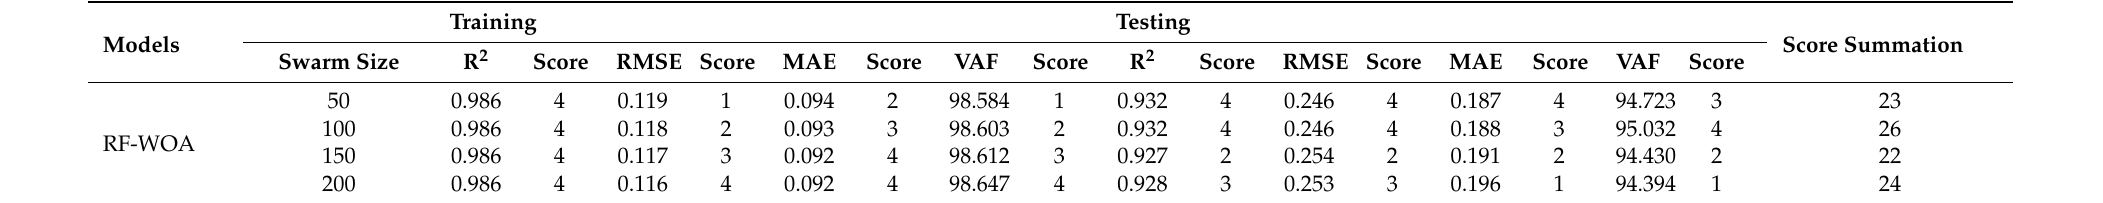
Table 3. Performance of different swarm sizes of the RF-WOA models on predicting the PPV.